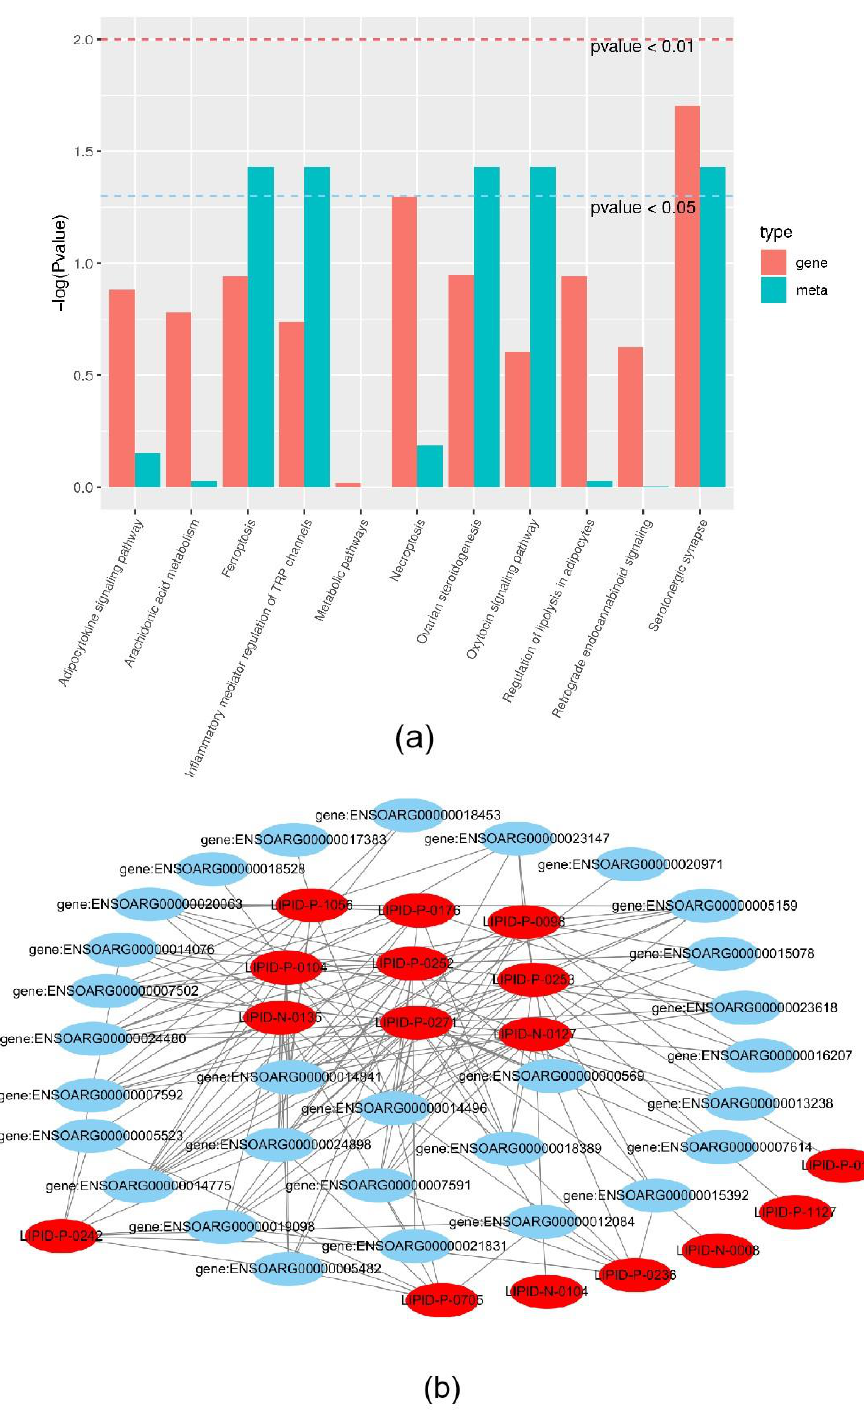
Figure 4. Joint analysis results: ( a ) the classification histogram of pathways in which differentially expressed genes and differential metabolites were enriched in KEGG analysis; ( b ) correlation network diagram of differentially expressed genes and differential metabolites. Red: differential metabolites; Blue: differentially expressed genes.